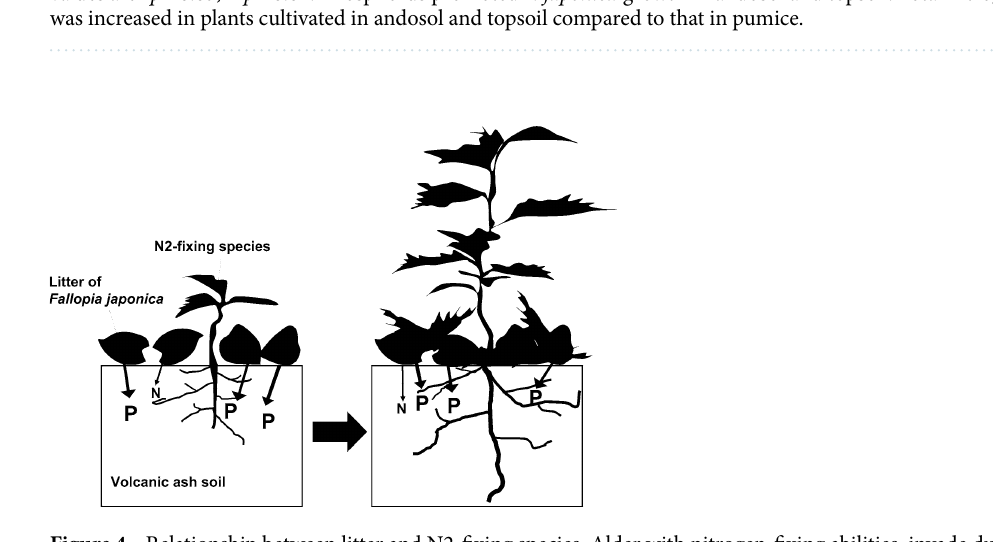
Figure 4. Relationship between litter and N2-fixing species. Alder with nitrogen-fixing abilities, invade during the middle of primary succession, gains phosphorus from new organic matter (e.g., fallen leaves of Fallopia japonica ) on the soil surface, and promotes